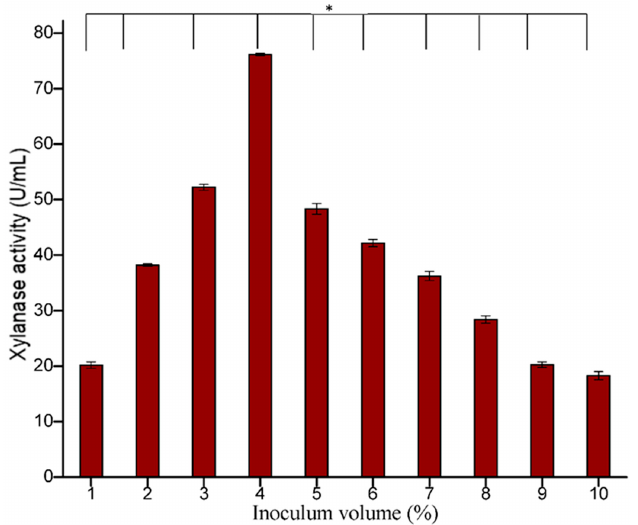
Figure 10. Optimization of inoculum size for the production of xylanase by B. safensis XPS7 (Medium: M5; temp.: 45 ◦ C; time: 24 h; pH: 9; inoculum: 1 to 10%). All the experiments were performed in triplicate. Bars display mean ± SD and statistical analysis was performed using a one-way ANOVA with a Tukey post hoc test, with p < 0.01